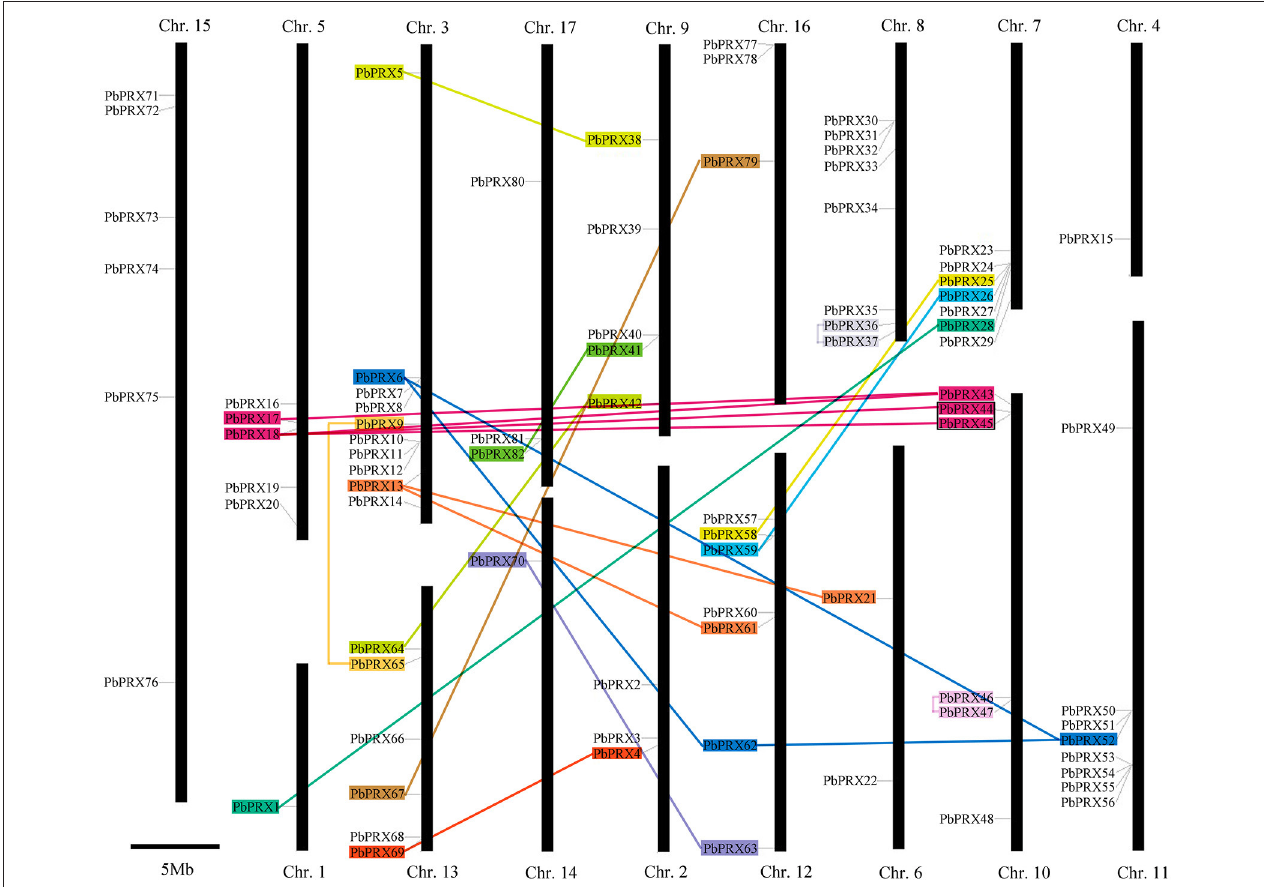
FIGURE 5 | Chromosomal locations of Pyrus bretschneideri Rehd PRX ( PbPRX ) genes. Segmental duplicates represented by color boxes and connected by color lines, and tandem duplicates are marked by black